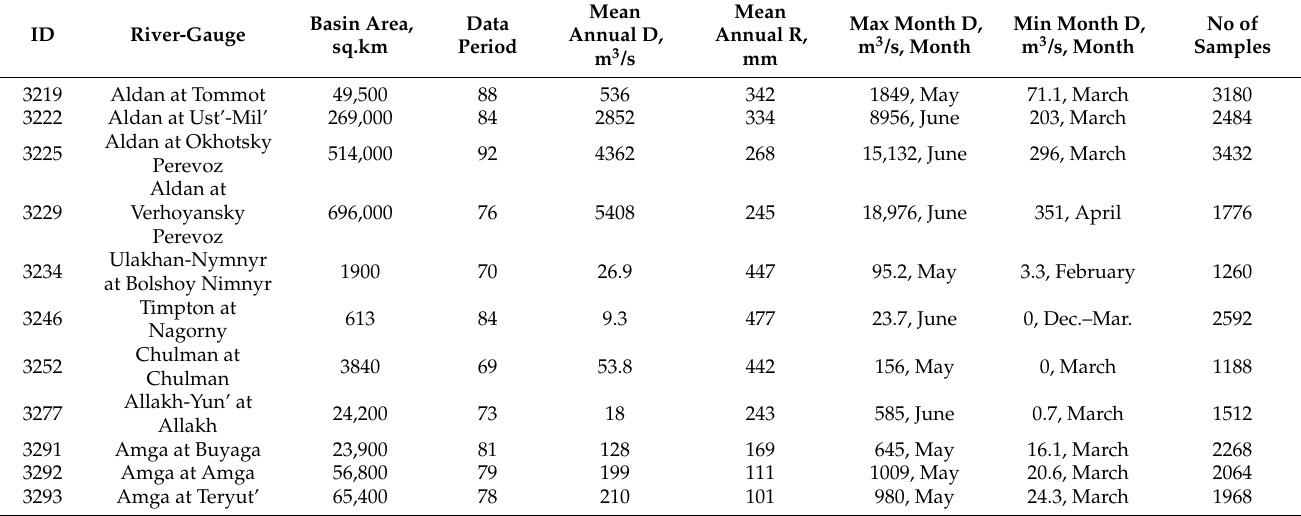
Table 1. Basic characteristics of river basins (ID, name, area, data period, mean annual discharge (D), mean annual runoff depth (R), maximum monthly D and corresponding month, min monthly D and corresponding month, number of analyzed